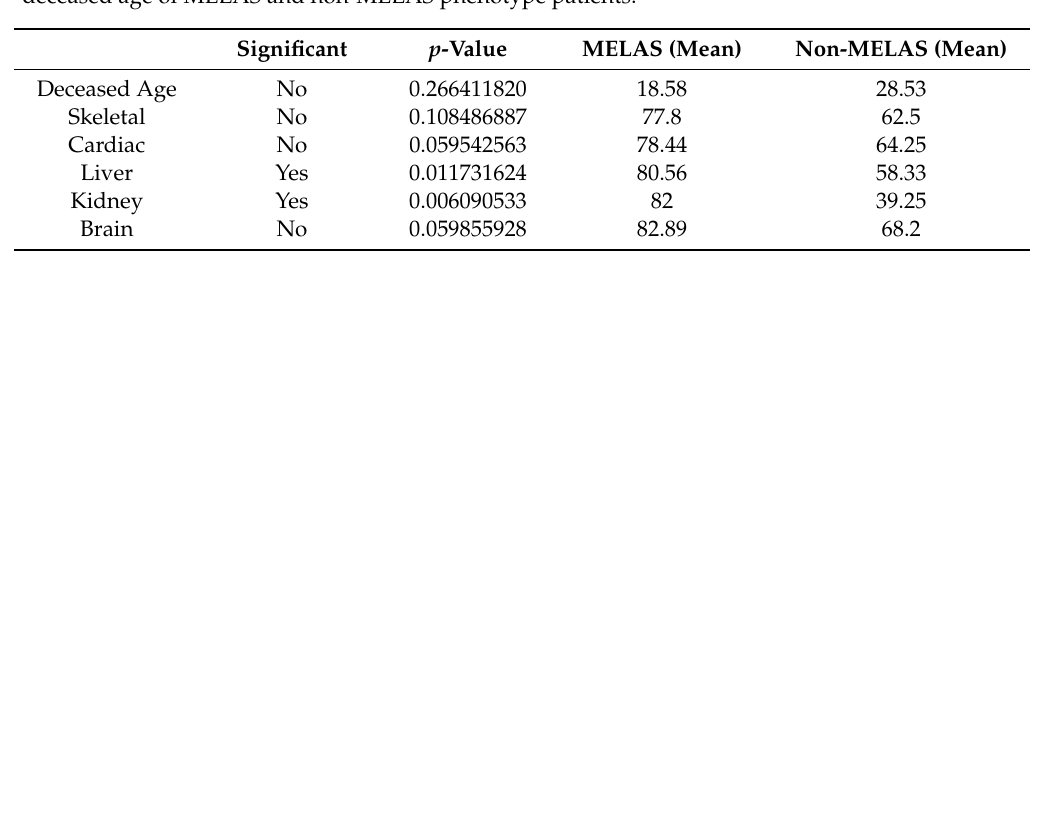
Table 3. Statistical analysis of heteroplasmy levels (%) of PM skeletal, PM cardiac and PM brain, and deceased age of MELAS and non-MELAS phenotype